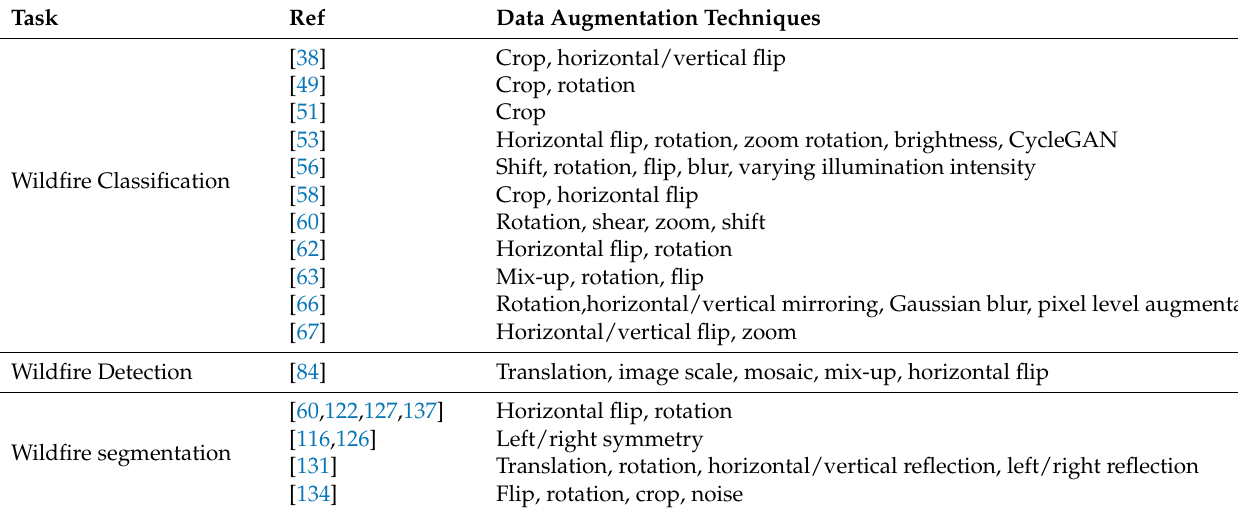
Table 5. Overview of data augmentation